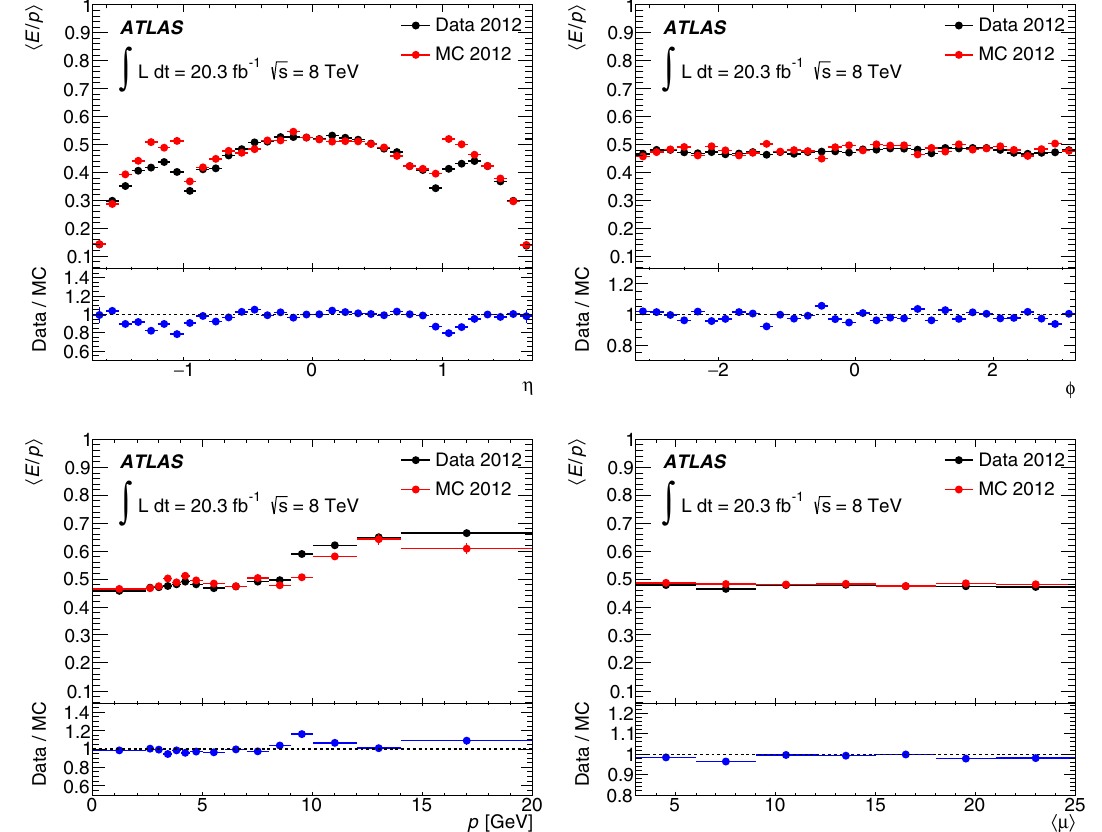
Fig. 24 Distributions of (cid:4) E / p (cid:5) as a function of η (top left), φ (top right), p (bottom left) and (cid:4) μ (cid:5) (bottom right) measured in 2012. Only statistical uncertainties are shown. The sources of systematic uncertainty are discussed in the